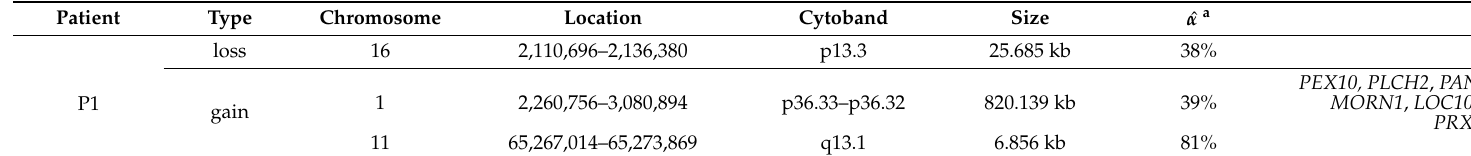
Table 1. Additional aberrations found in patients P1, P2 and